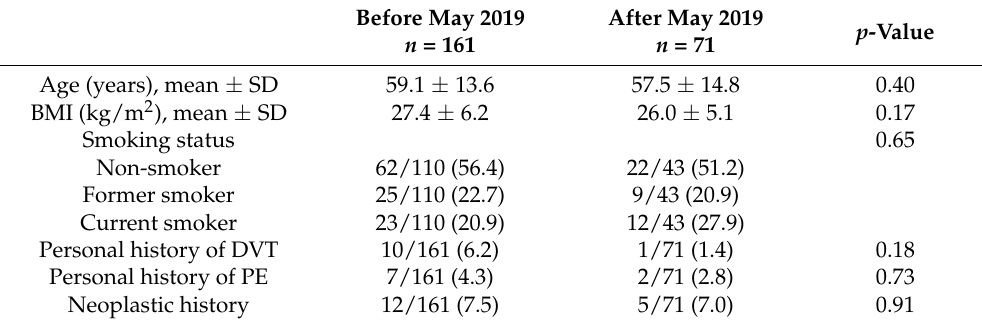
Table 2. Comparison of the baseline characteristics of the patients according to JAKi initiation before vs. after May 2019.